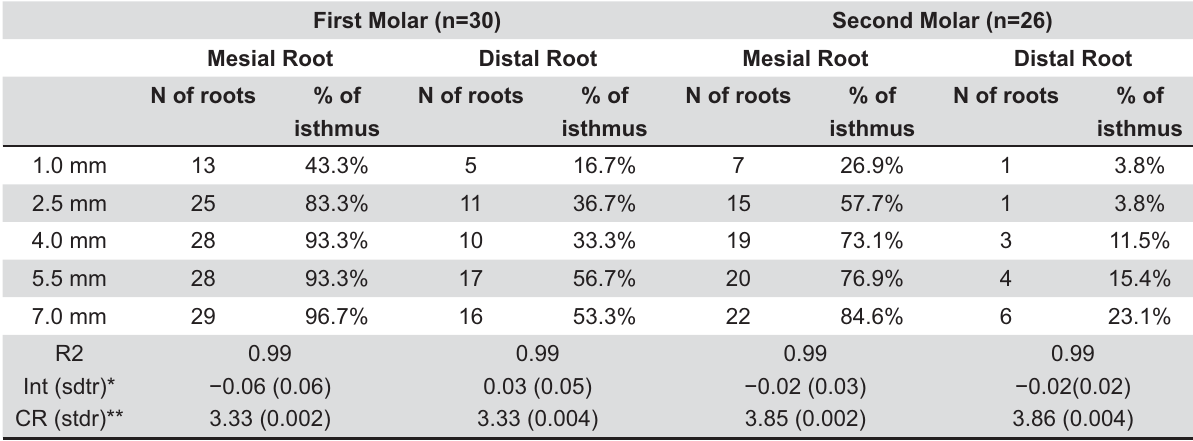
Table 5- (cid:2)&(cid:18)(cid:8)(cid:26)(cid:21)(cid:14)(cid:18)(cid:2)(cid:11)(cid:15)(cid:18)(cid:8)(cid:5)(cid:15)>(cid:14)(cid:8)(cid:15)(cid:12)(cid:7)(cid:2)(cid:9)(cid:6)(cid:6)(cid:12)(cid:5)(cid:11)(cid:15)(cid:7)(cid:10)(cid:2)(cid:8)(cid:12)(cid:2)(cid:8)(cid:26)(cid:4)(cid:15)(cid:5)(cid:2)(cid:21)(cid:12)(cid:5)(cid:19)(cid:26)(cid:12)(cid:17)(cid:12)(cid:10)(cid:15)(cid:6)(cid:2)(cid:6)(cid:17)(cid:9)(cid:18)(cid:18)(cid:15)(cid:13)(cid:6)(cid:9)(cid:8)(cid:15)(cid:12)(cid:7)